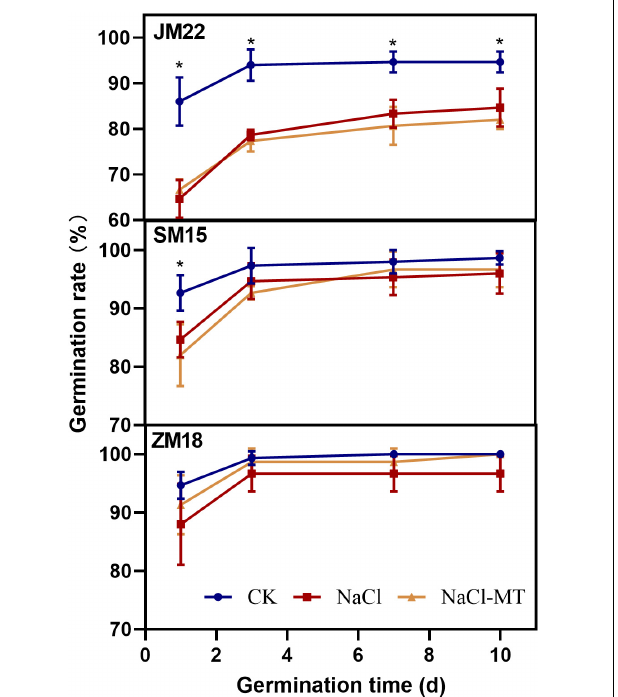
FIGURE 1 | Effects of MT on germination trait under salt stress. For each trait, asterisks represent significantly different according to Duncan’s test at a p < 0.05